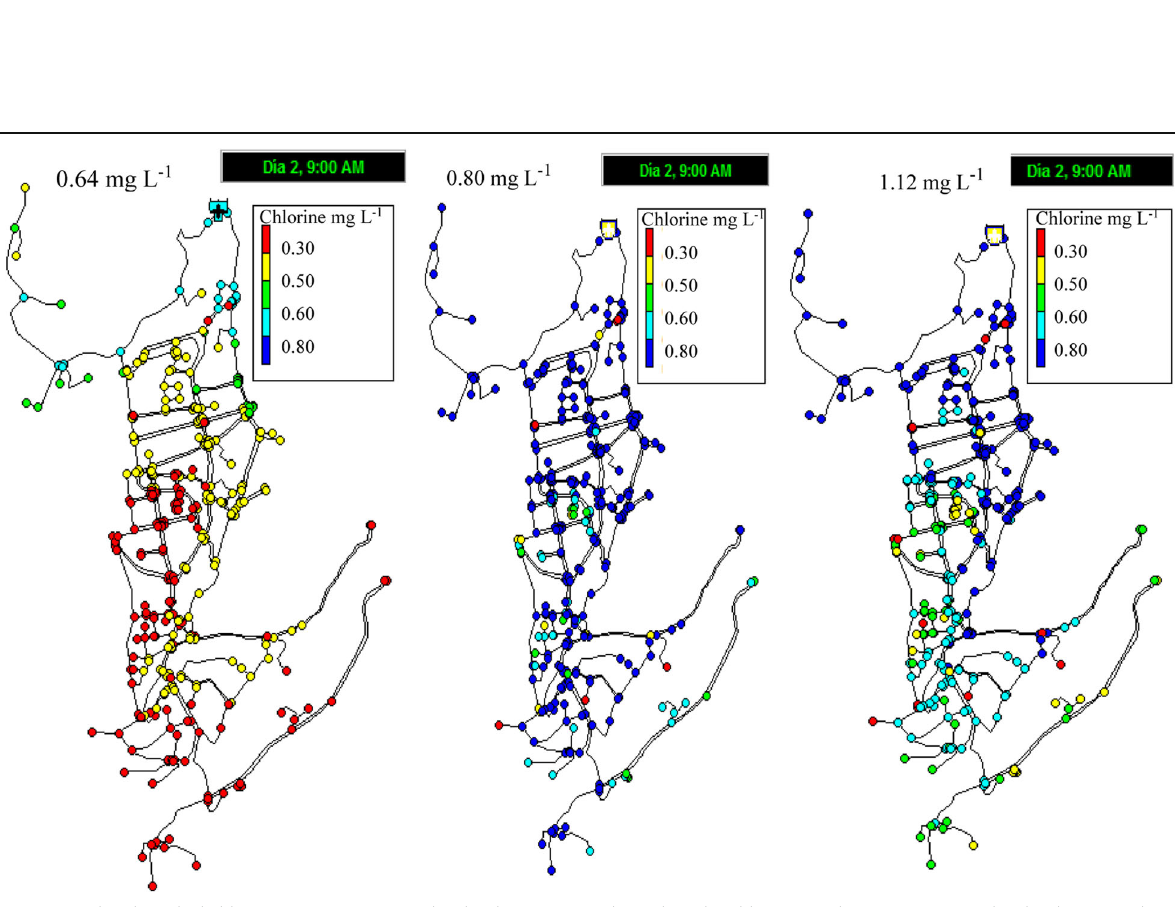
Fig. 8 Simulated residual chlorine concentrations in the distribution network. a When the chlorine initial concentration in the distribution tank was 0.64 mg L − 1 , b When the chlorine initial concentration was 0.80 mg L − 1 , c When the chlorine initial concentration was 0.87 mg L −